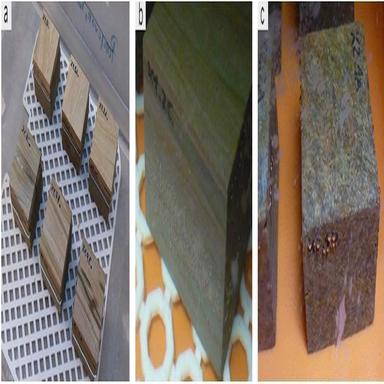
Water absorption at atmospheric pressure on XL specimens: (a) deeper and faster water rising using foliation joints on P-oriented specimen; (b) and (c) expulsion of internal air through foliation joints and voids.